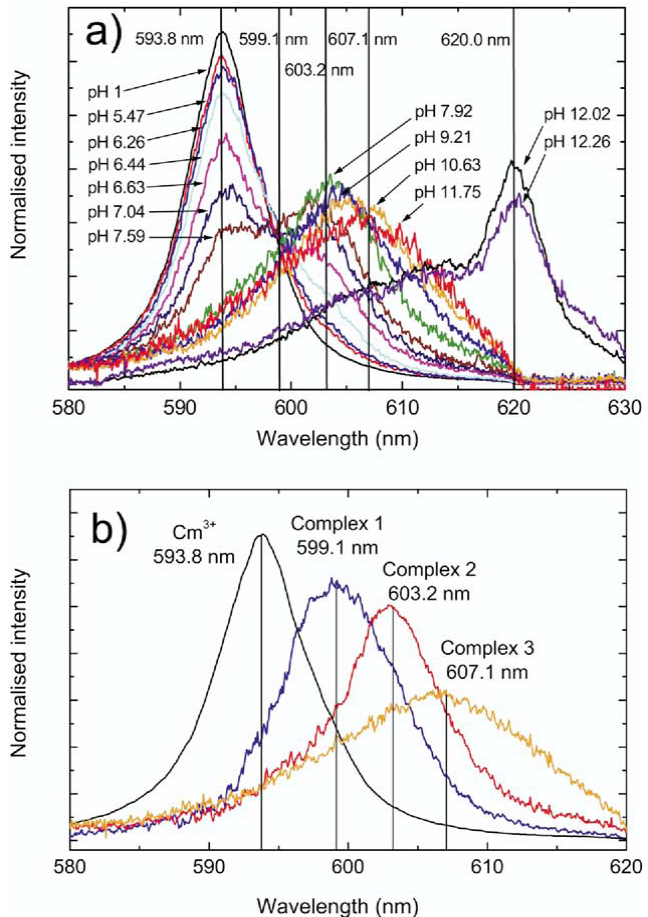
Figure 6. Cm-fluorescence spectra at different pH values in the presence of Ca-montmorillonite. (a) Cm fluorescence spectra normalized to same peak area. Total Cm concentration = 2.5 × 10 -7 mol/L, m/V ratio = 0.25 g/L, 0.066 mol/L Ca(ClO Spectra of individual surface complex species derived from peak deconvolution.